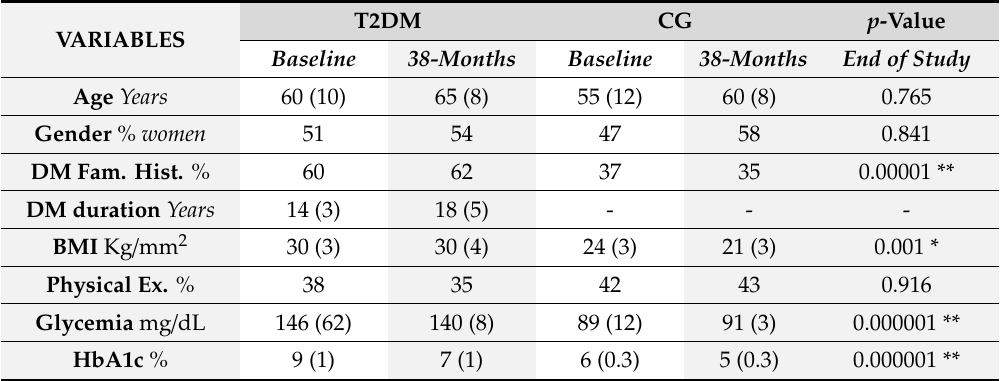
Table 2. Demographics, lifestyle, and classical biochemical blood traits in the study participants. Similar age and distribution by gender, but significant di ff erences regarding the glycemic profile were observed between the T2DM patient vs. The CG throughout the